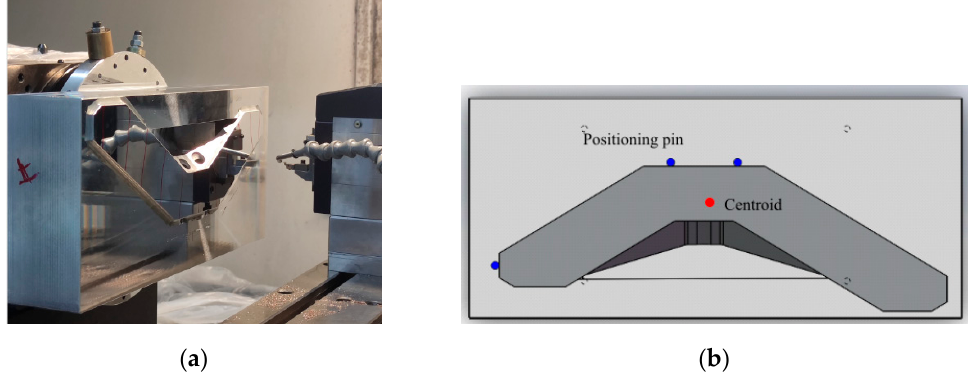
Figure 14. ( a ) FTS system and ( b ) a schematic diagram of the mirror and fixture